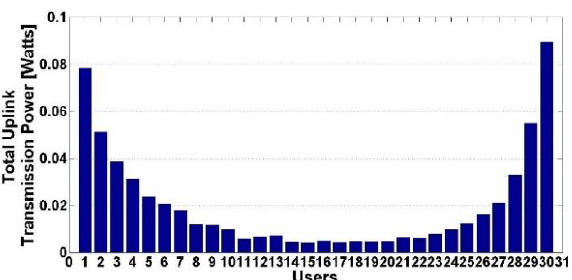
Fig. 4. Users’ total uplink transmission power allocation for increasing discount factor: δ i+1 = δ i +0.007 , δ 1 =0.777.